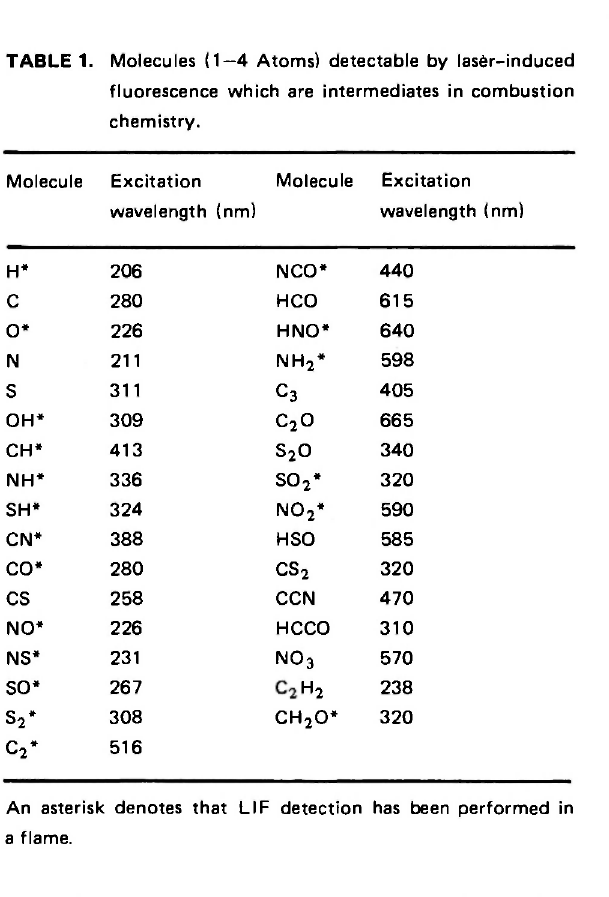
TABLE 1. Molecules (1—4 Atoms) detectable by lasfir-induced fluorescence which are intermediates in combustion